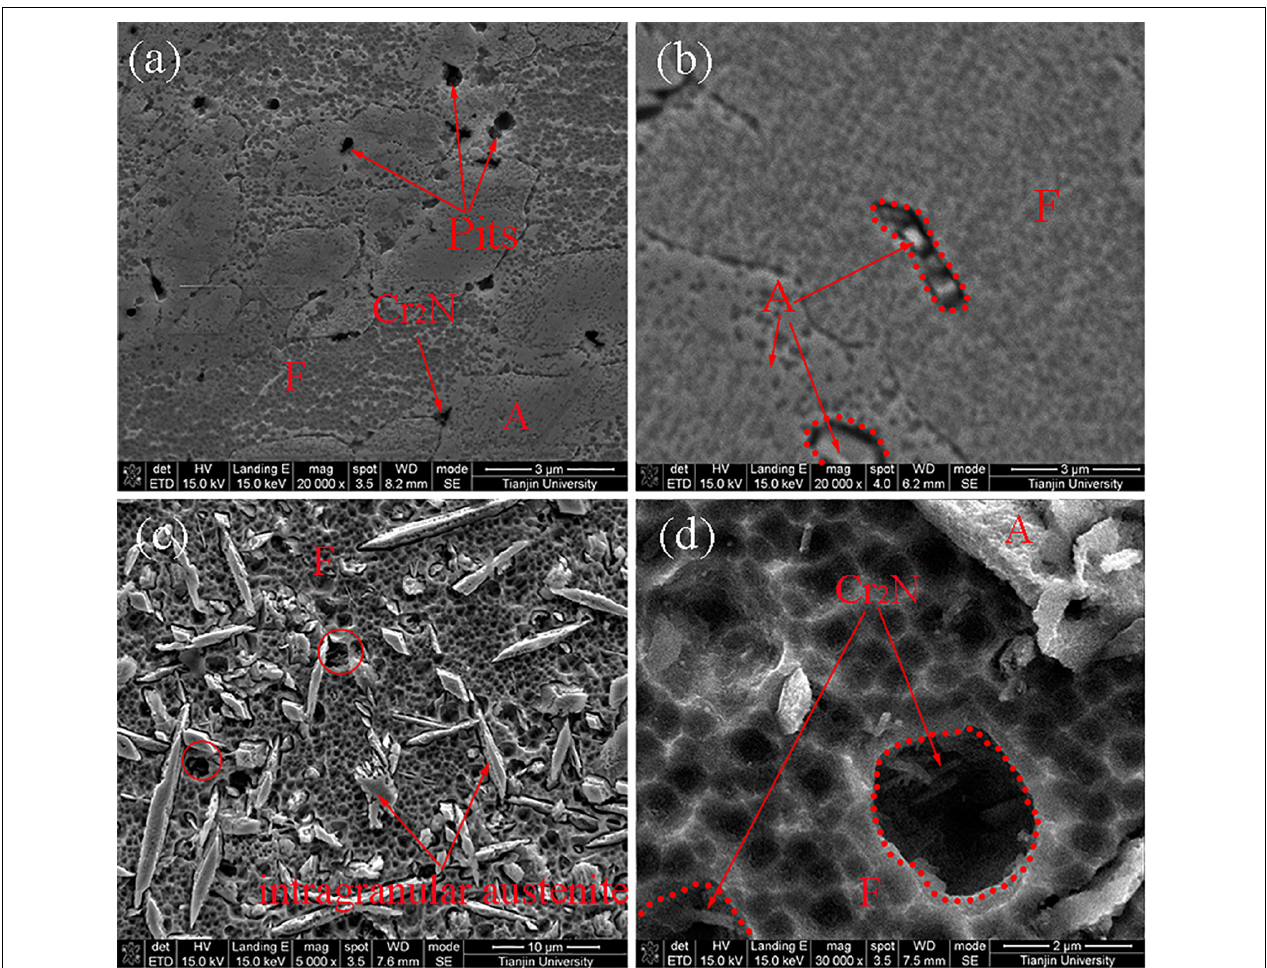
FIGURE 9 | SEM pits morphologies in WM after CPT tests: (a) the weld cap, (b) the weld center, (c,d) the HAZ.